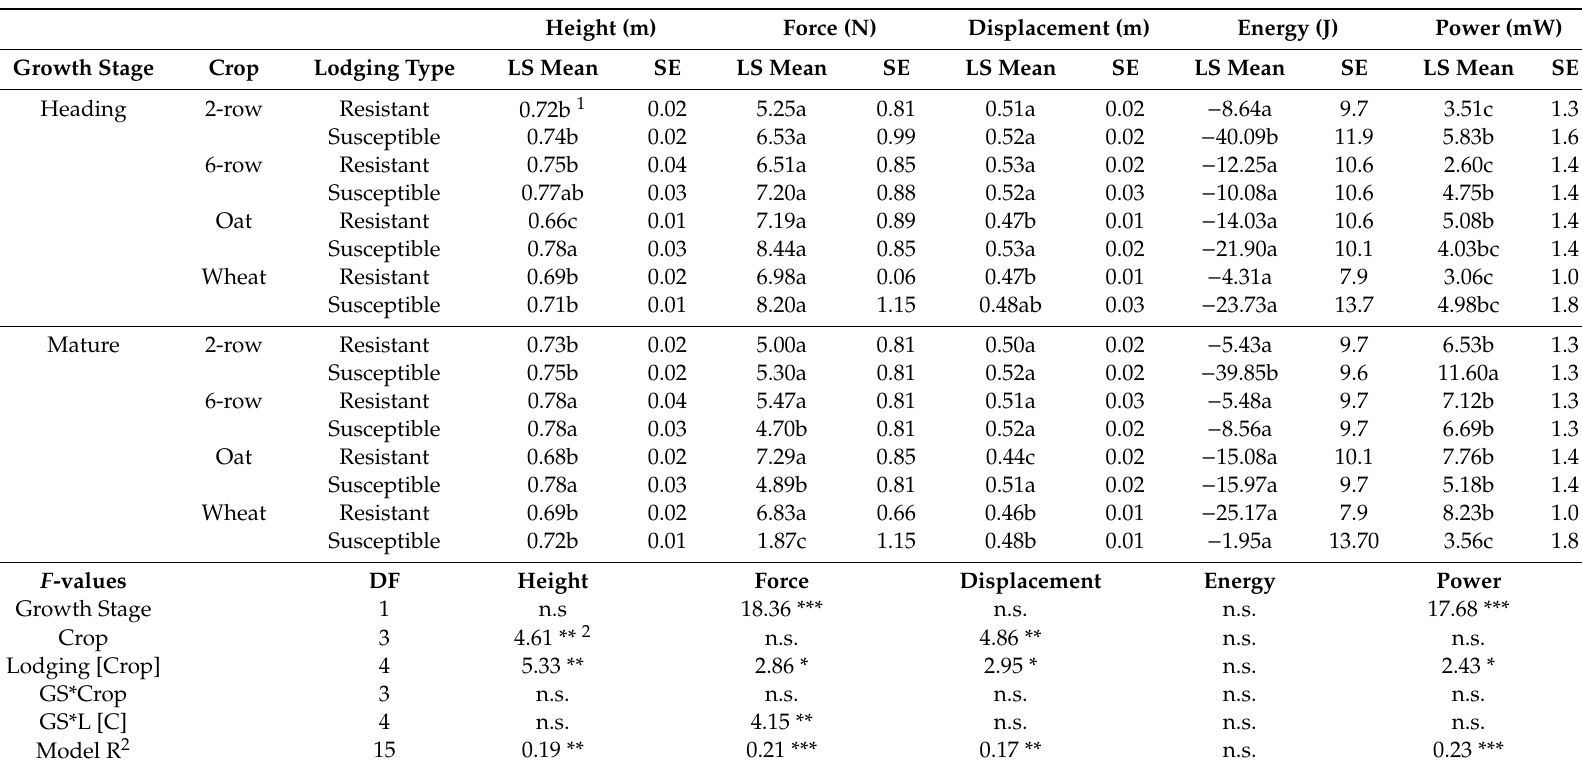
Table 3. Crop trait least square means calculated by the push-force meter organized by growth stage and lodging classification nested within the cereal